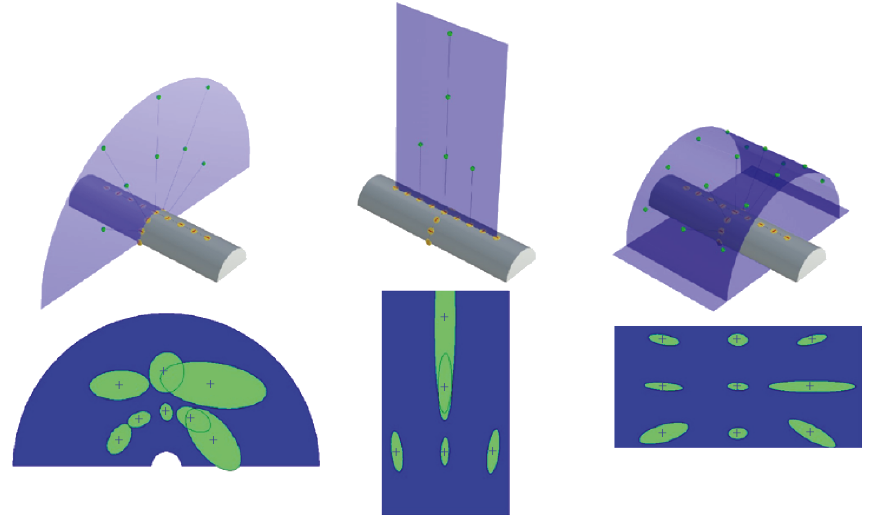
Figure 7: Ellipses display Cramer Rao bounds for di ff erent dipole locations by projecting on three